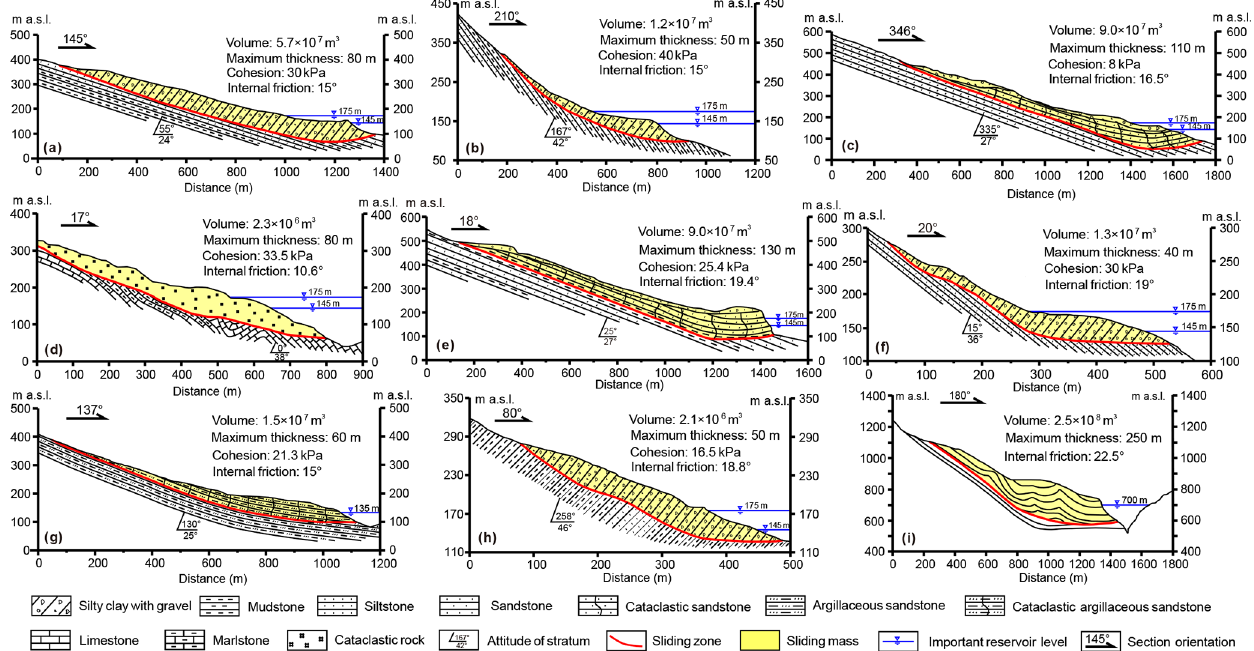
Figure 1. Geological profiles for typical reservoir landslides, all in the TGR except Vajont in Italy (I). (a) Jiuxianping landslide (Wang, 2013); (b) Xicheng landslide (Song, 2011); (c) Outang landslide (Yin et al., 2016); (d) no. 1 riverside slump of Huangtupo landslide (Wang et al., 2014); (e) Muyubao landslide (Lu, 2012); (f) Baishuihe landslide (Lu, 2012); (g) Qianjiangping landslide (Xiao et al., 2007); (h) Ganjuyuan landslide (Qin, 2011); (i) Vajont landslide, the world-famous reservoir-induced landslide in Italy (Paronuzzi and Bolla, 2012). See Fig. 2 for locations.